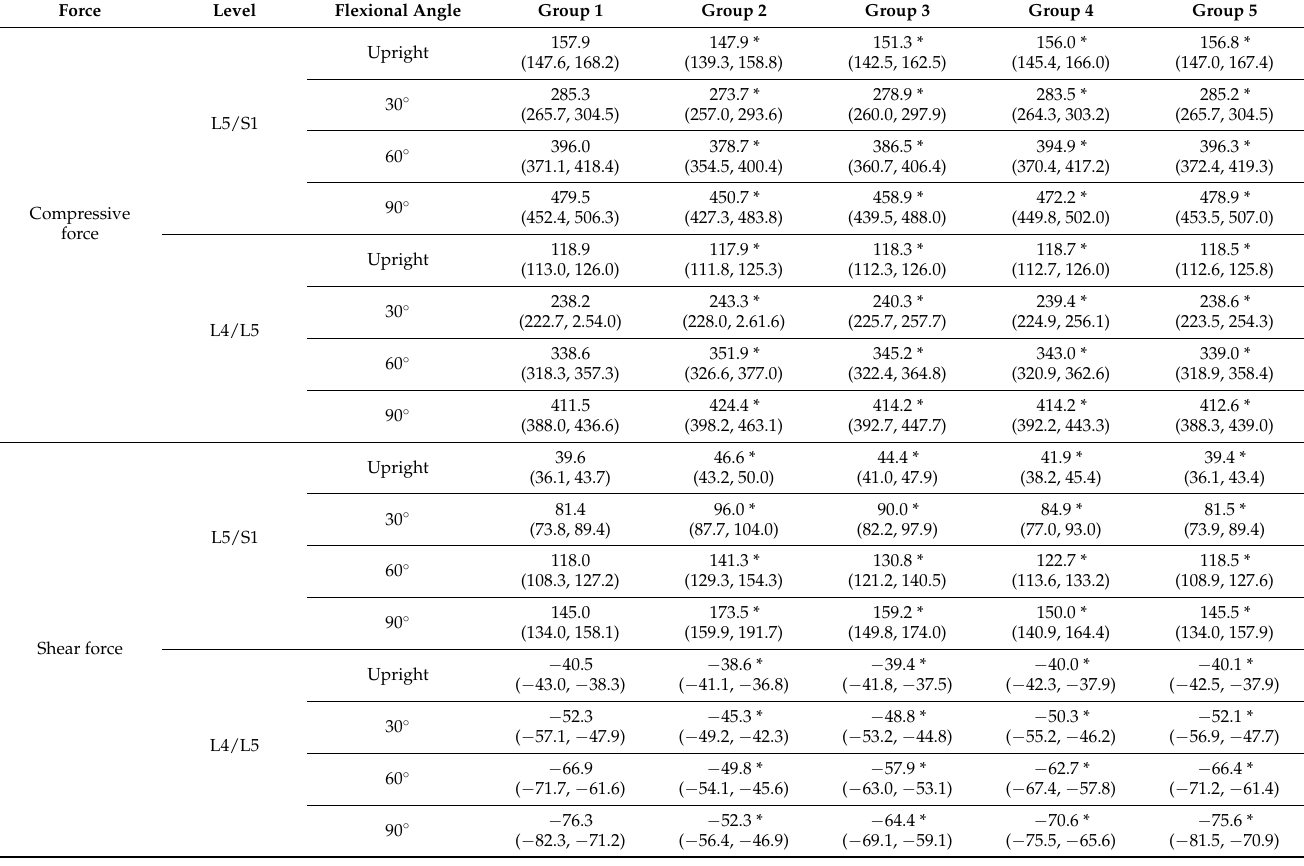
The medians, 25th and 75th percentiles of the normalized compressive forces and shear forces on the L5/S1 and L4/L5 levels under four trunk flexional angles in the five groups were reported in Table 2. The statistical analyses show that the normalized compressive forces and shear forces on the L5/S1 and L4/L5 levels from group 2–5 were significantly different ( p < 0.001) compared with group 1 in each posture. Table 2. Normalized compressive force and shear force expressed by % upper body weight (UBW) with medians, 25th, and 75% percentiles on the L5/S1 and L4/L5 levels. Values from group 2–5 were compared with group 1 using Wilcoxon matched-pairs signed-ranks test (* indicates p < 0.001). Group 4 Group